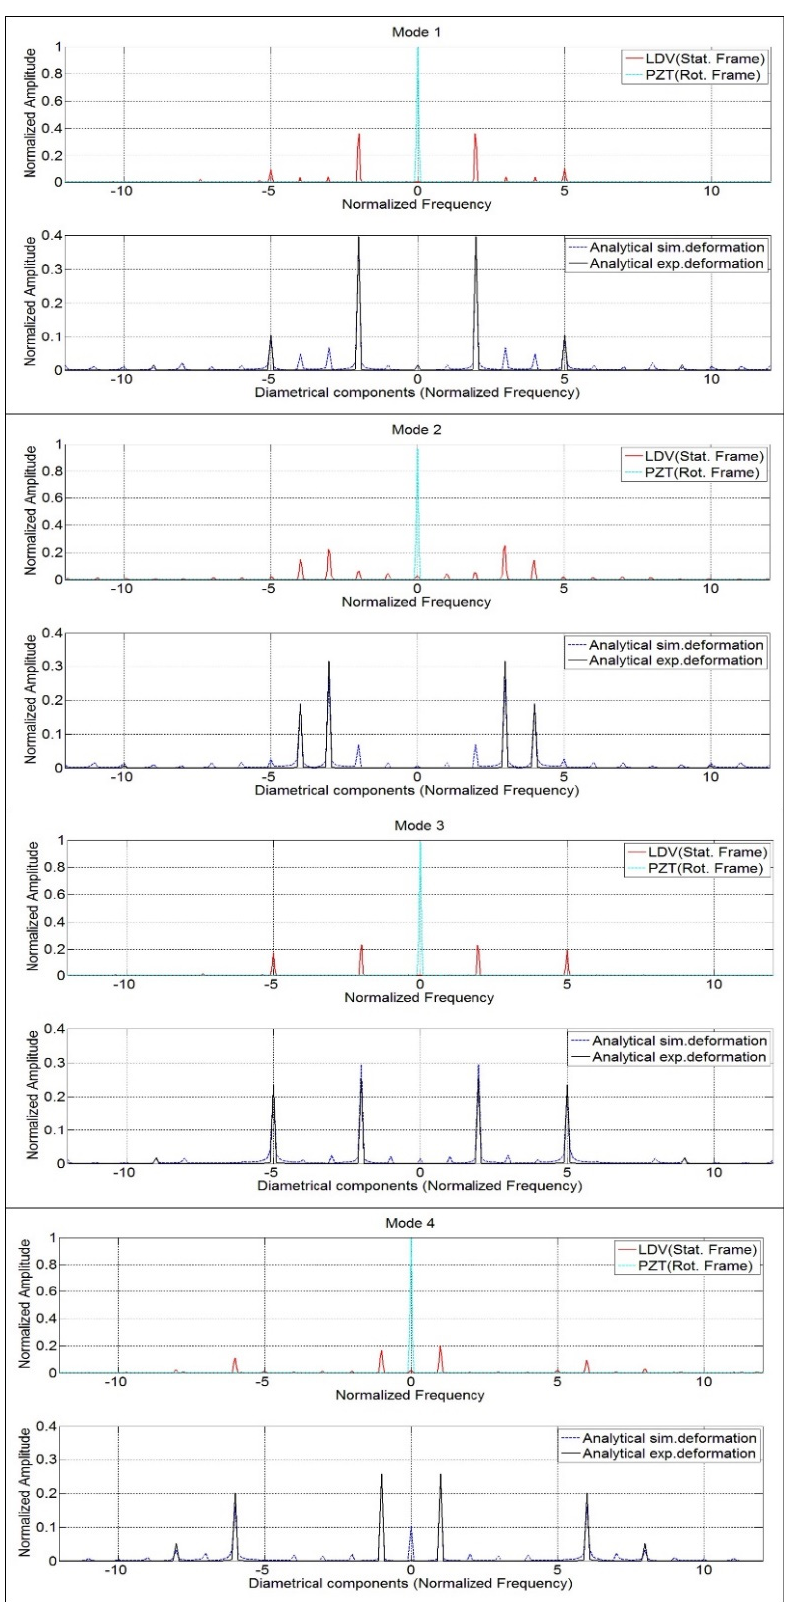
Figure 16. Experimental results for the frequencies detected with the stationary sensor (LDV) and its relationship to the diametrical components obtained with the mode shape decomposition.